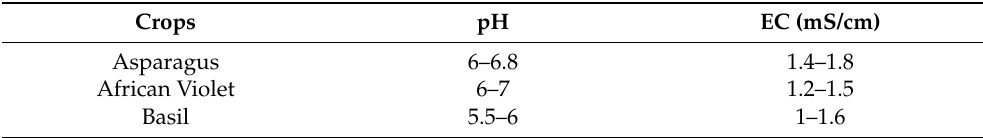
Figure 2. Effect of pH on the availability of nutrients. Out of the 5–7 pH interval, nutrient availability gets compromised by chemical reactions between the components of the nutrient solution [32]. Table 4. Optimum range of electrical conductivity (EC) and pH for some popular hydroponic crops